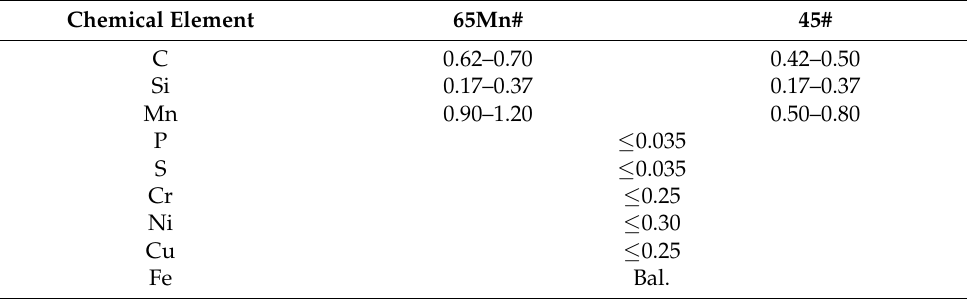
Table 4. Nominal chemical composition of the steel of 65Mn# and 45#